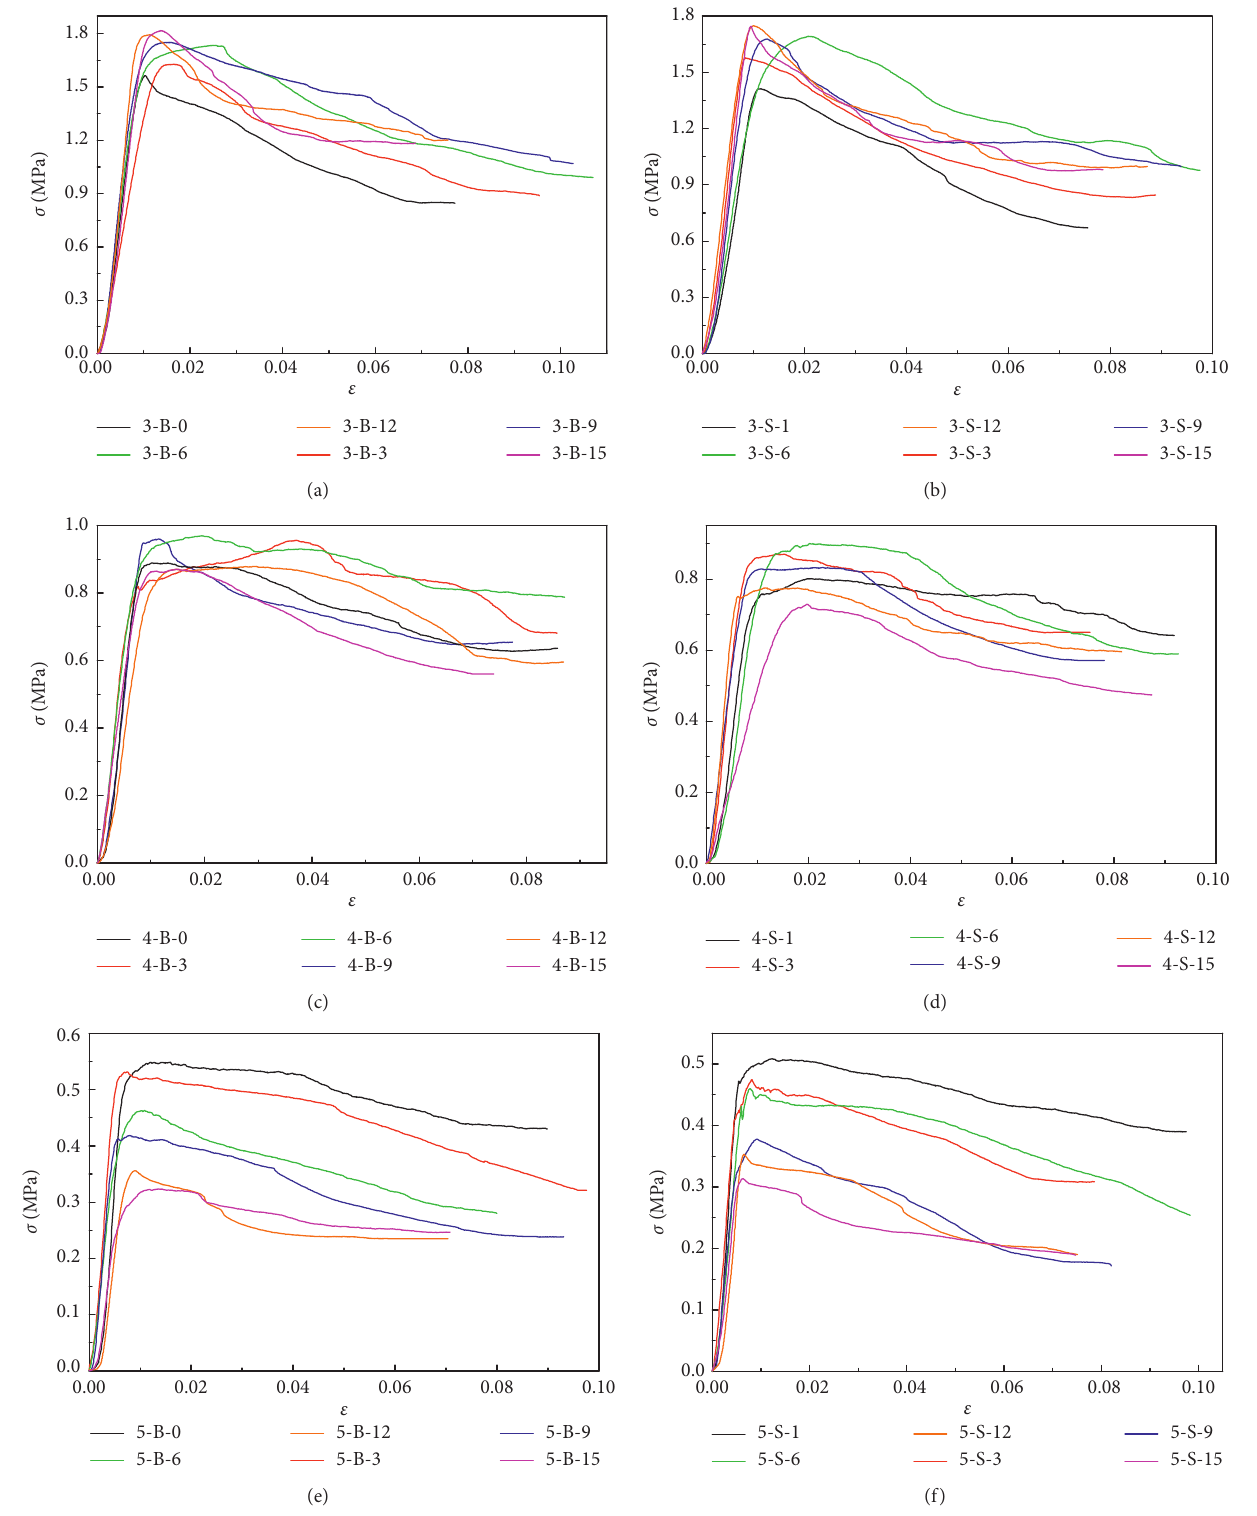
Figure 4: Stress-strain curves of specimens under different dry-wet cycles: (a) 3:1 saturated; (b) 3:1 dehydrated; (c) 4 :1 saturated; (d) 4:1 dehydrated; (e) 5 :1 saturated; (f) 5 :1